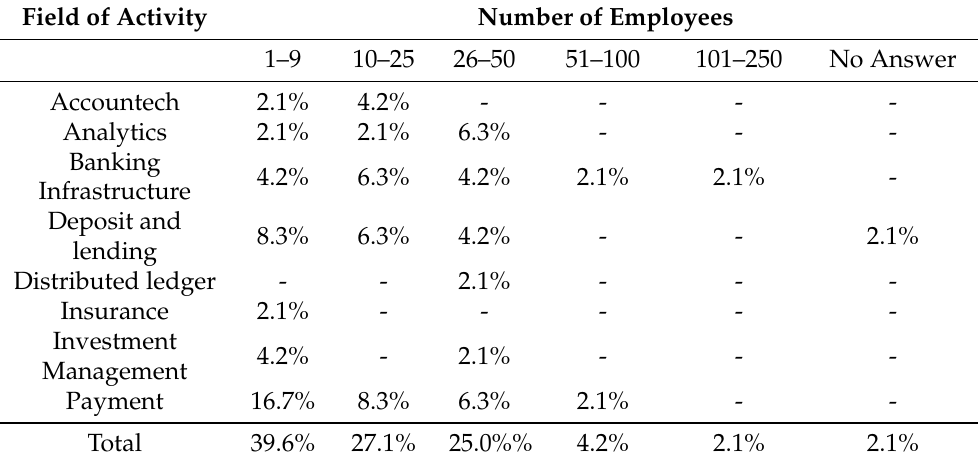
Figure 3. Maturity of companies by field of activity. Table 3. Number of employees versus the field of